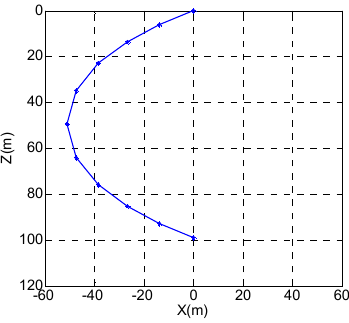
Figure 17. Initial cable shape in the vertical plane.